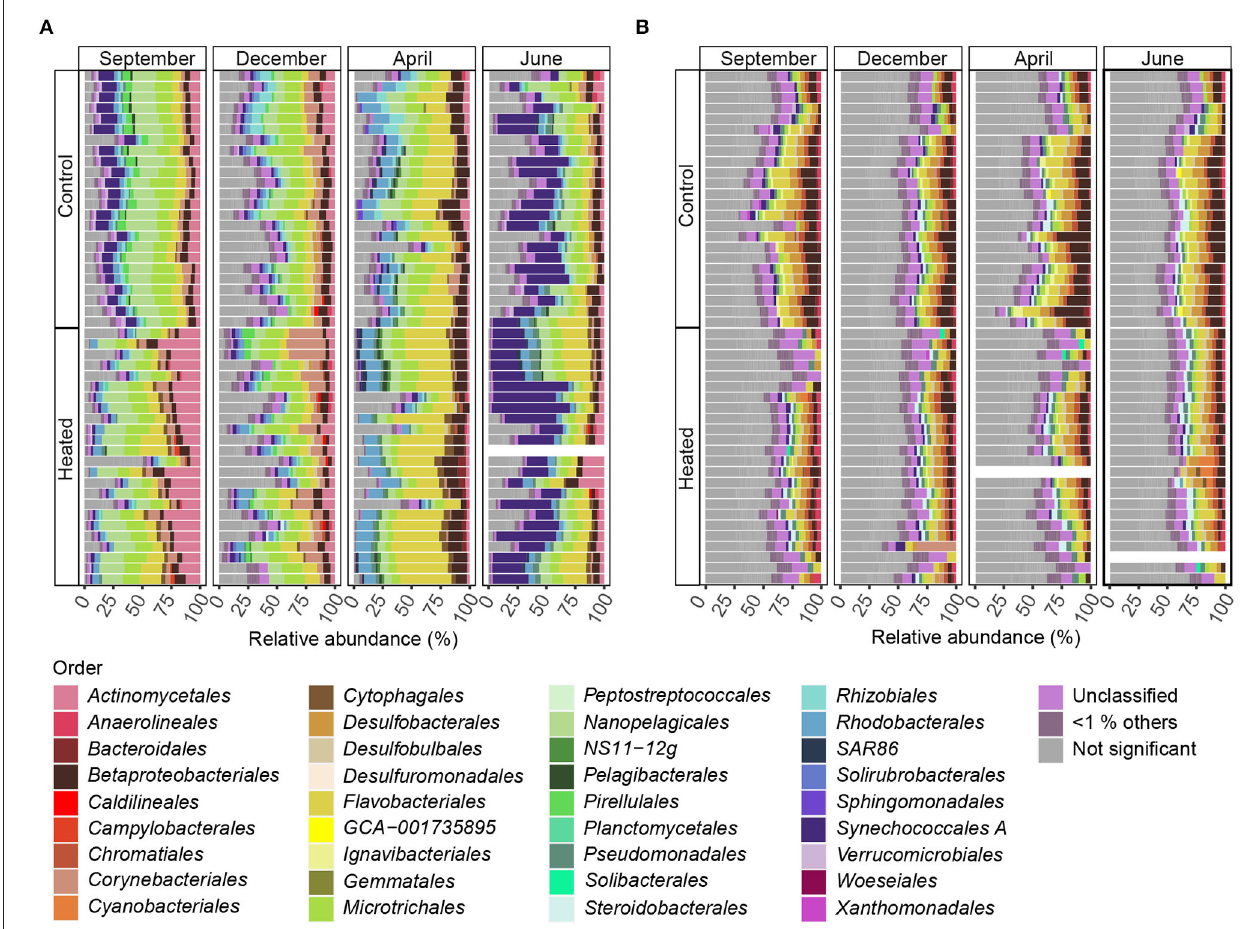
FIGURE 4 | Differentially abundant ASVs summarized means on the order level for bottom water and sediment. Stacked bars of significant differentially abundant ASVs between the heated and control bays (both n = 191) for the different sampling months for (A) bottom water and (B) sediment. The x-axes show the relative abundance summed to 100%, while the y-axis shows the bays with rows representing sampling sites ( n = 8) and replicates ( n = 3). Shown are significant differentially abundant ASVs with summarized mean on the order level above 1% relative abundance (significant ASVs below 1% relative abundance are grouped as “ < 1% others” and insignificant differentially abundant ASVs between bays as “not significant.” Samples with low read numbers have been excluded (see Materials and Methods). The stacked bars are read from right to